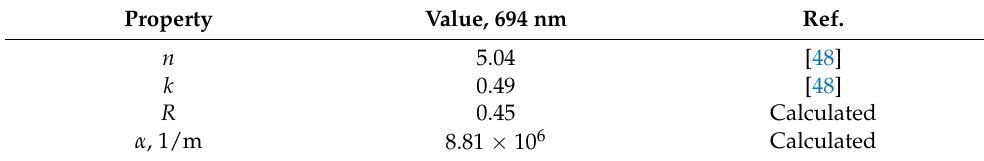
Table A6. c -Ge—optical properties.